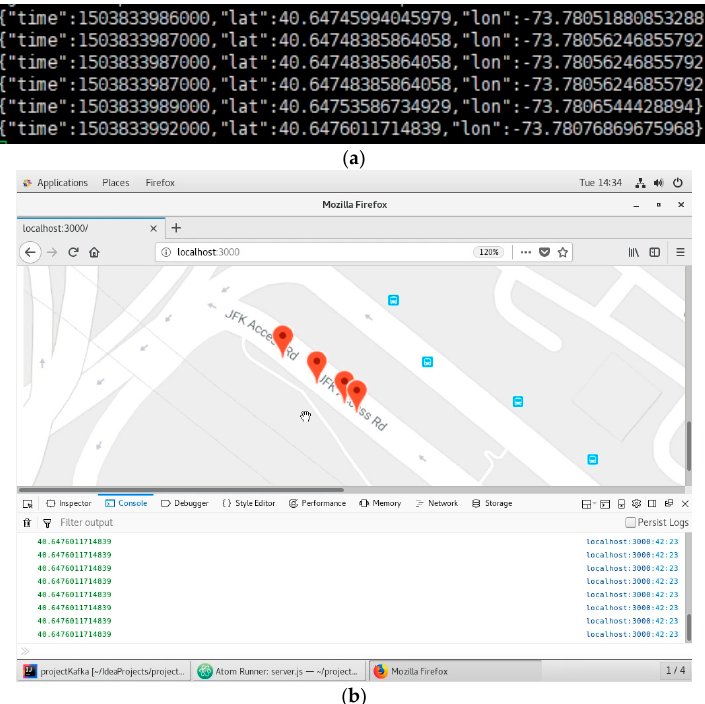
Figure 14. ( a ) Location information transmitted when Spark detects abnormal data; ( b ) web-based visualization of the messages delivered to the central LDM.